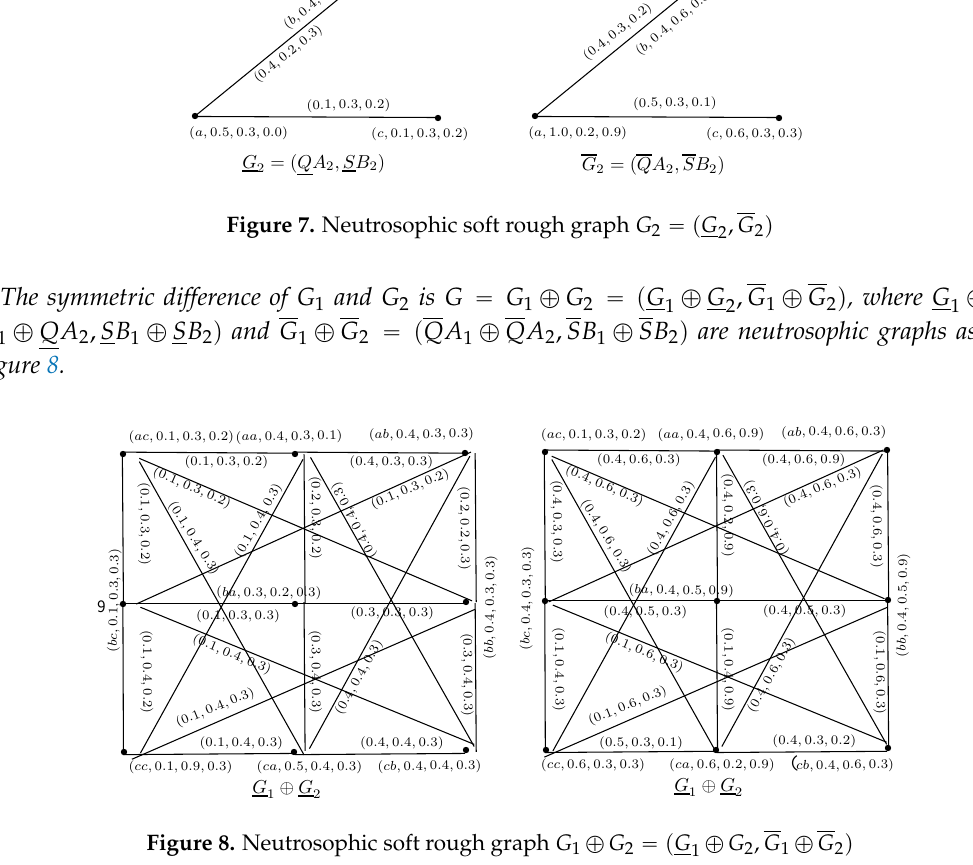
Figure 8: Neutrosophic soft rough graph G 1